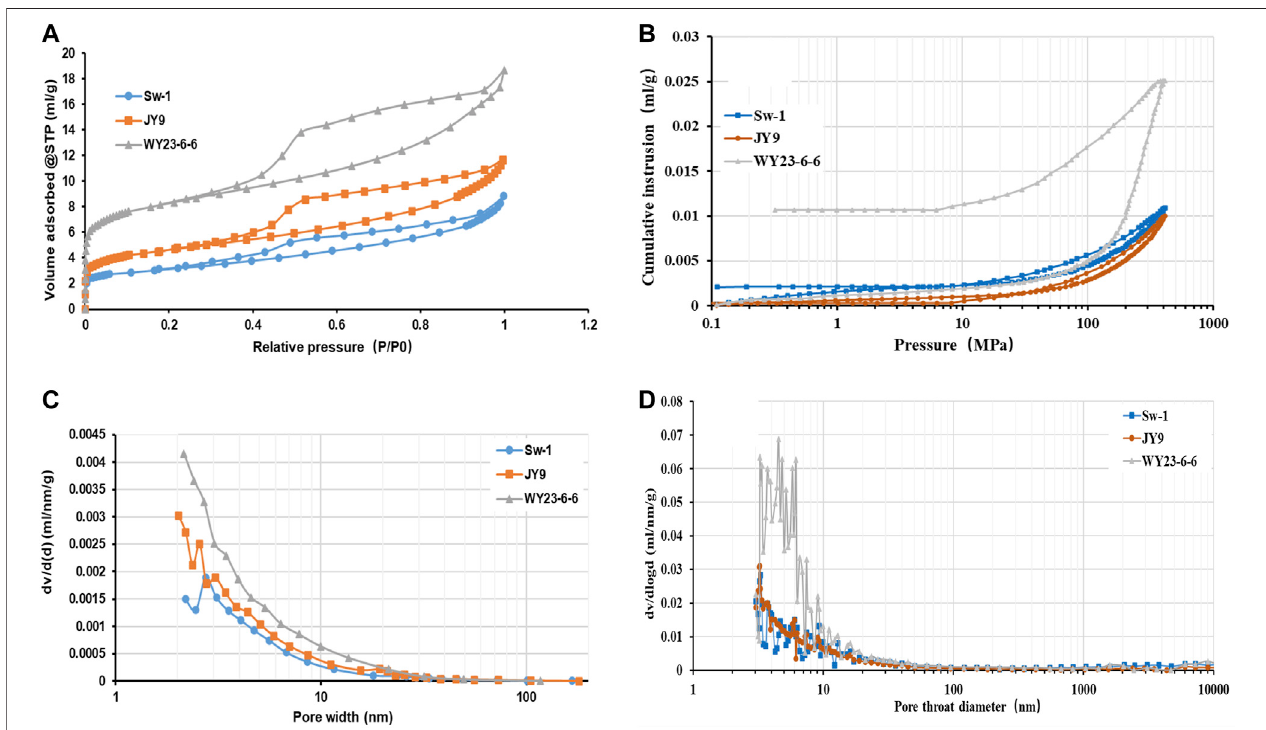
FIGURE 6 | N 2 adsorption isotherms and MICP results for the three shale samples. (A) Isotherms of N 2 adsorption and desorption. (B) Mercury intrusion and extrusion curves. (C) dV/d(d) plots derived from N 2 adsorption data. (D) dV/log(d) plots derived from MICP data.